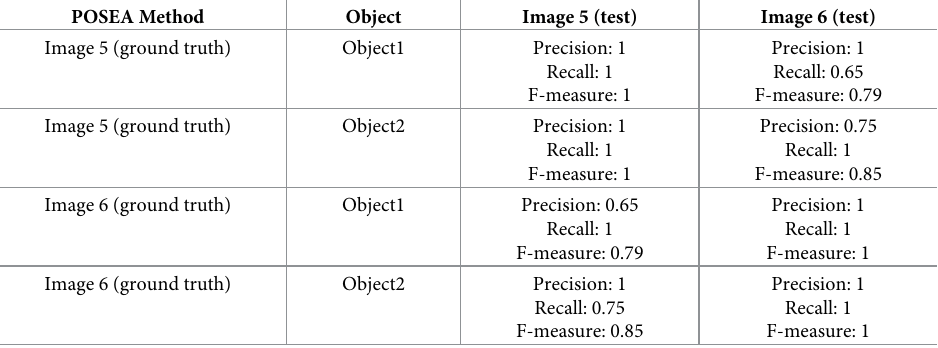
Table 3. Precision, Recall, F-measure values output from POSEA per cell evaluation of the simulated grayscale images of adjacent cells (Fig